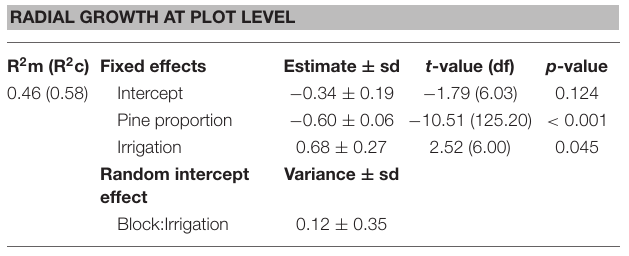
TABLE 3 | Summary of simplified linear mixed effects models of pine radial growth (vigor) at plot and tree level. RADIAL GROWTH AT PLOT